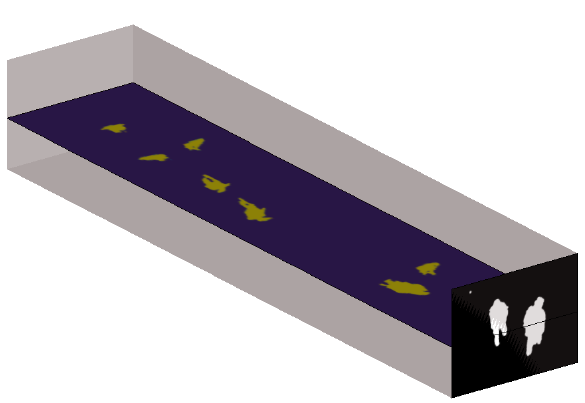
Figure 7. 2D+1D data cube for visualizing Kinect height differ- ence